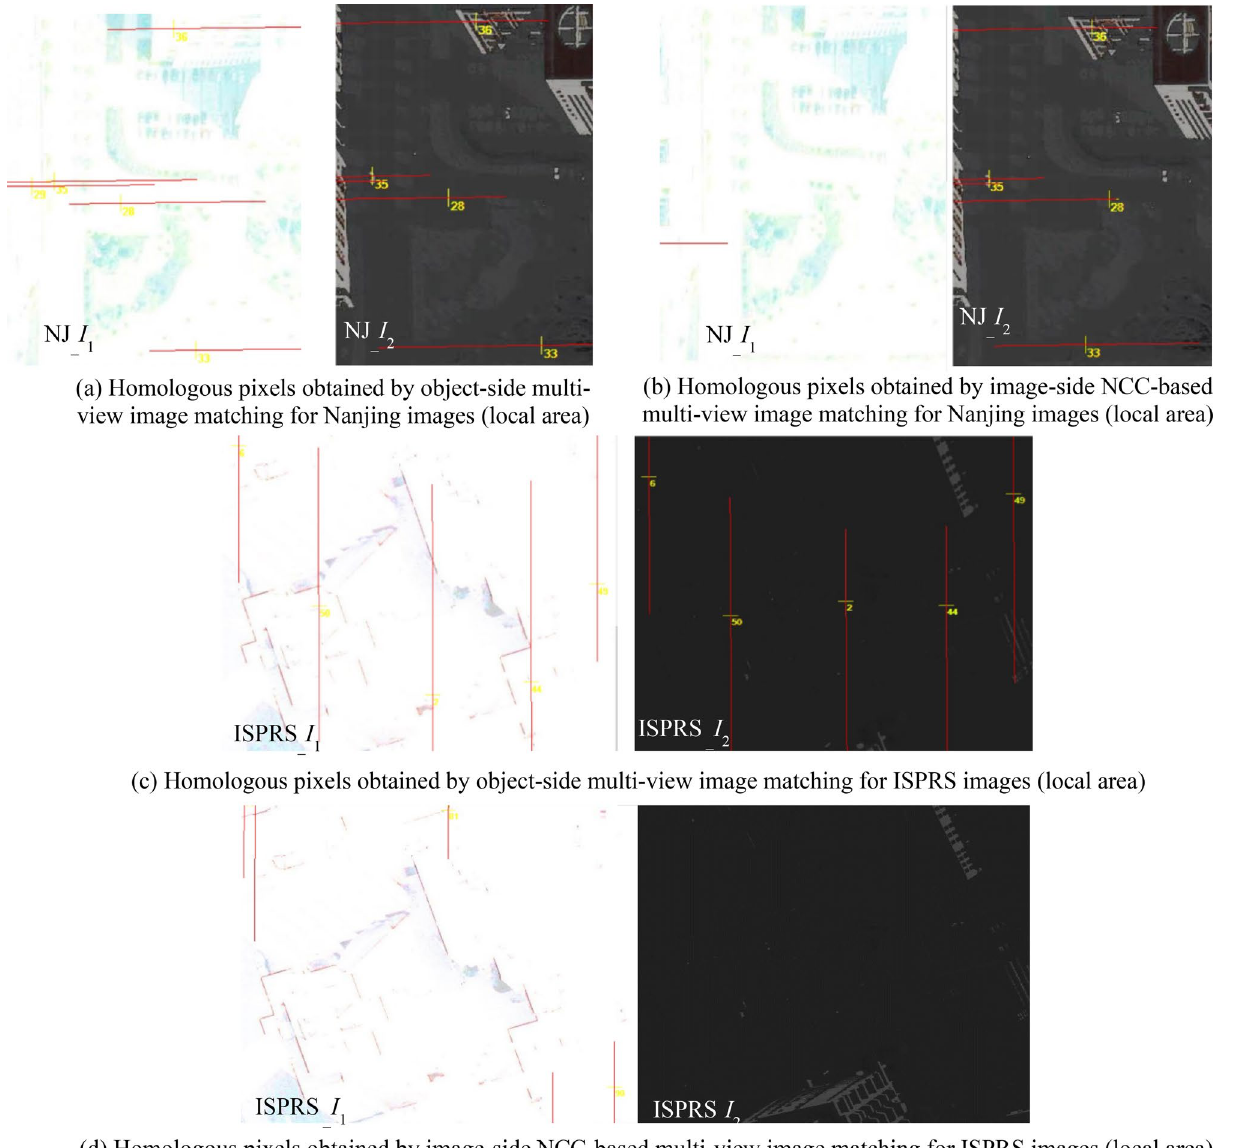
Figure 11. The comparative image-space experimental results of object-side and image-side multi-view matching methods for grayscale adjusted Nanjing and ISPRS images: NJ_ I 0 -NJ_ I 1 -NJ_ I 2 and ISPRS_ I 0 - ISPRS_ I 1 -ISPRS_ I 2 (All displayed images in this figure were generated by our own program realized using the Visual C#,NET